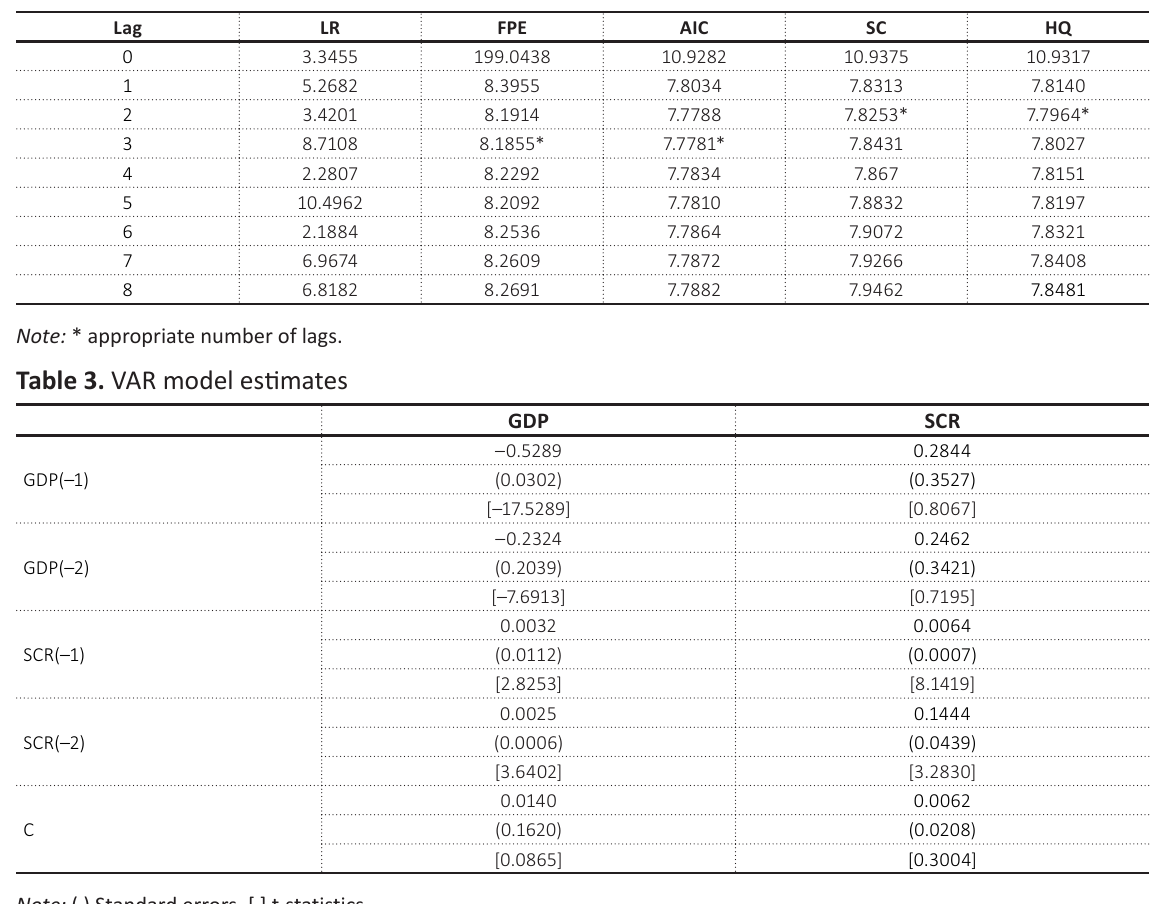
Table 2. Lag order selection criteria